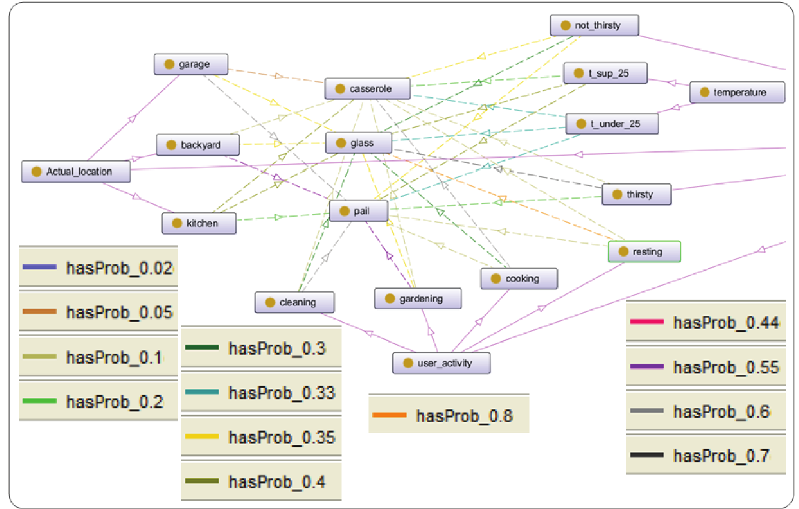
Fig. 9. Likelihood probabilities